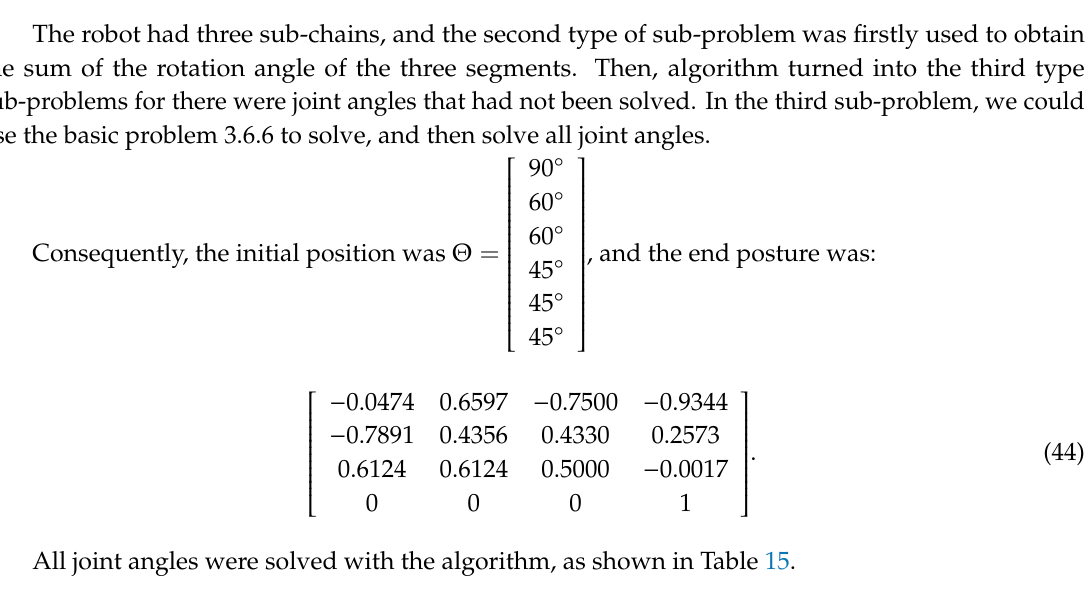
Table 15. Four inversely solved joint angle